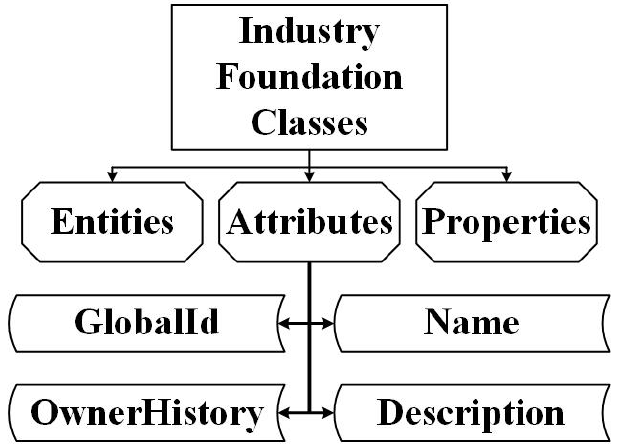
Figure 3. Basic components of the Industrial Foundation Classes.